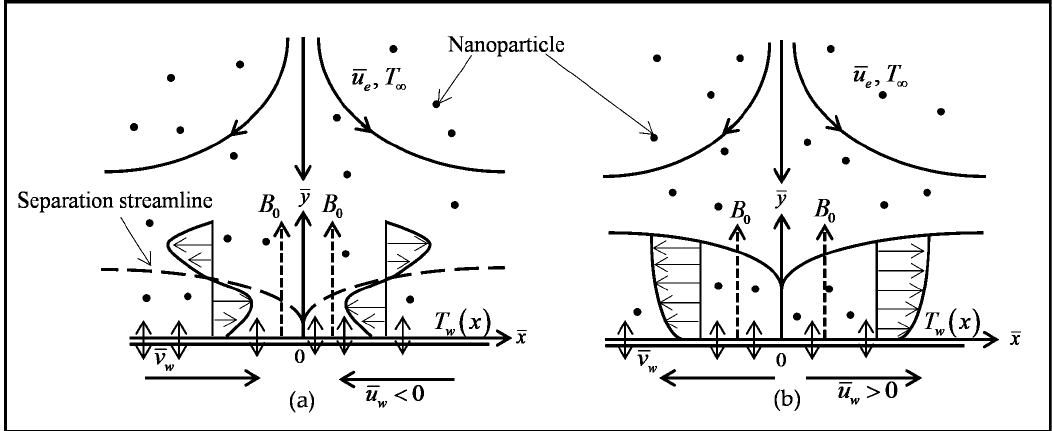
u  ; ( b ) stretching sheet w